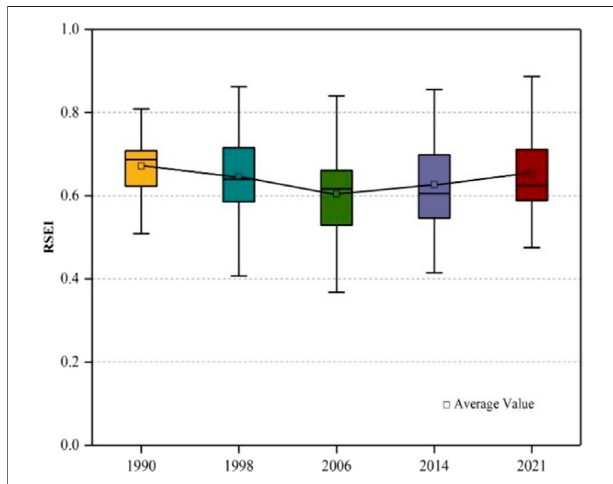
FIGURE 3 | RSEI data box diagram of Jianghan Plain from 1990 to 2021.